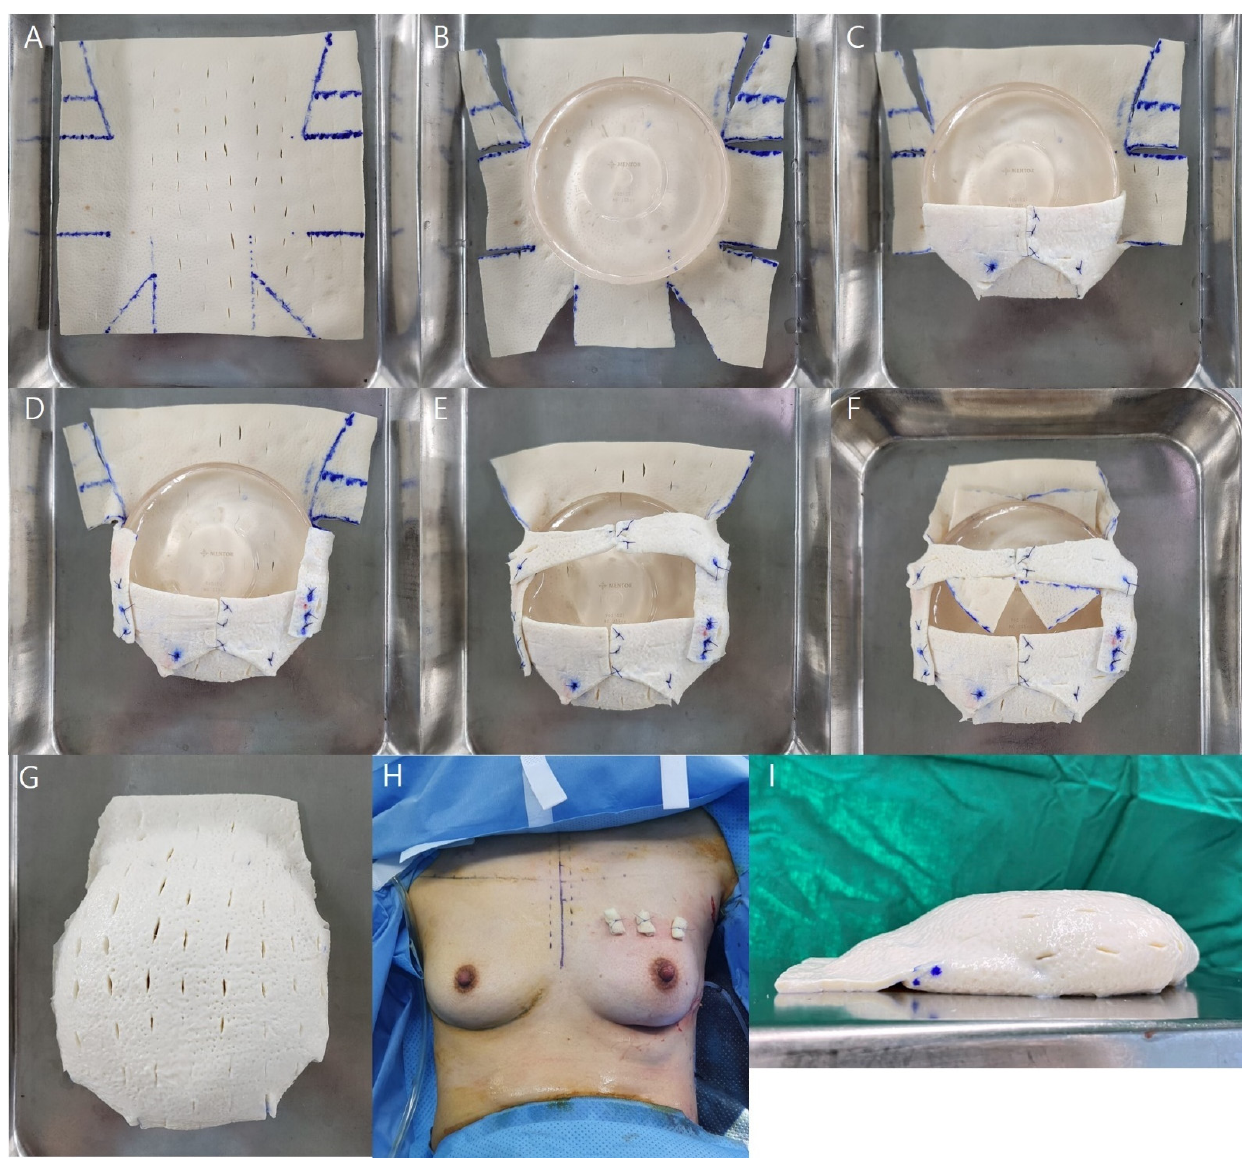
Figure 2. Acellular dermal matrix (ADM) wrapping and surgical procedures in the intraoperative field. ( A ) Wrapping design for ADM. ( B ) ADM cut and implant placement. ( C ) The middle part of the bottom is folded inward first, and both sides are sutured to the center. ( D ) Both middle sides are folded and fixed at the lower pockets. ( E ) Both lateral upper sides are gathered at the center and fixed. ( F ) Two of the cut triangles created from the bottom are sutured to the area not covered by the ADM, and the two created from the top are fixed to the upper ADM for upper pole volume replacement. ( G ) Frontal view of the wrapped ADM. ( H ) Intraoperatively, the implant is fixed to the upper pole with a bolster using the pullout suture technique. This 38 ‐ year ‐ old patient was diag ‐ nosed with invasive breast cancer of the left breast; the resected breast tissue weighed 224 g. A 170 ‐ cc breast implant and CGDerm ® 18 × 18 cm 2 were placed inside. ( I ) Lateral view of the implant wrapped with ADM. The upper pole without implants is filled with ADM to form a natural slope.